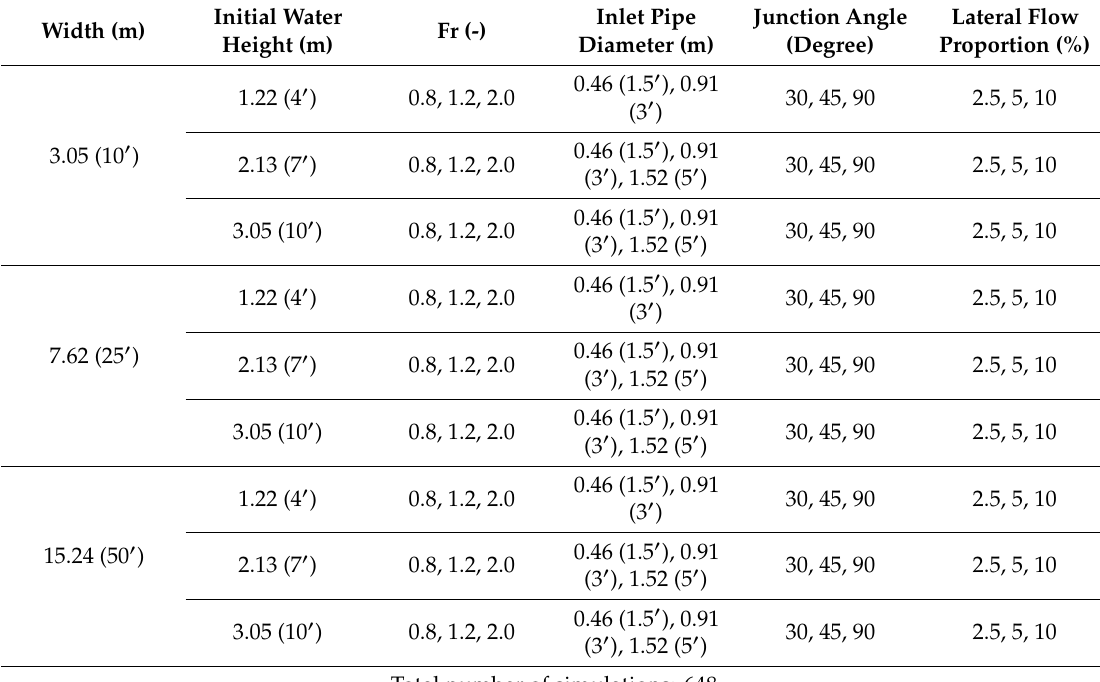
Table 2. Simulation